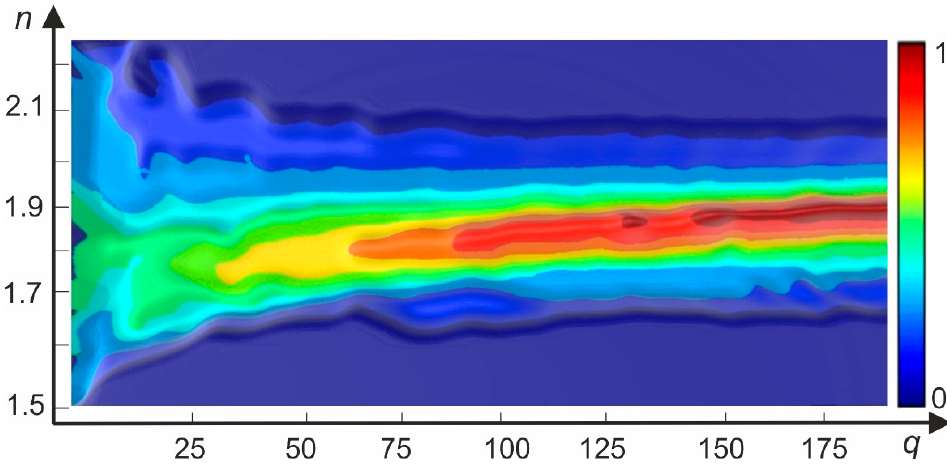
Figure 1. QBS function for polydisperse (10% for particle diameter) mesoscale dielectric spheres vs. Mie size parameter q . Adopted from [36].